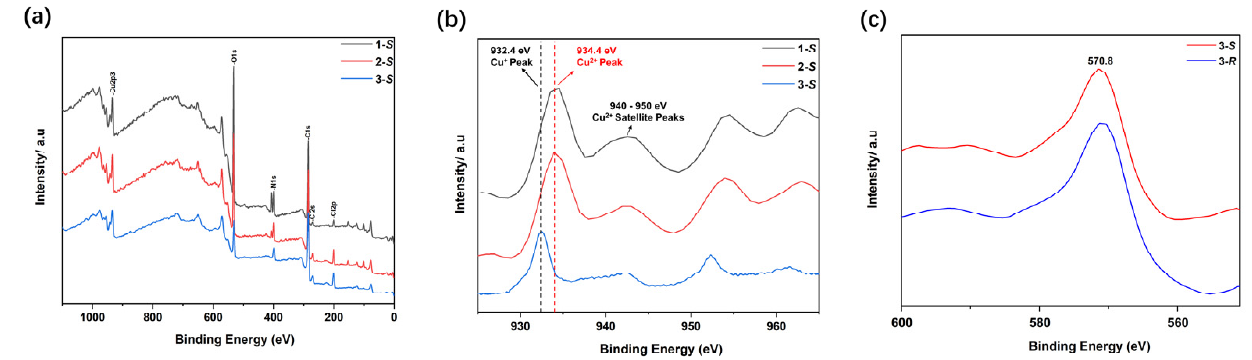
Figure 7. ( a ) Survey XPS spectra of 1- S , 2- S and 3- S ; ( b ) typical Cu 2p 3/2 XPS spectra for 1- S , 2- S and 3- S ; ( c ) Cu + LMM XPS spectra of 3- S and 3- R .